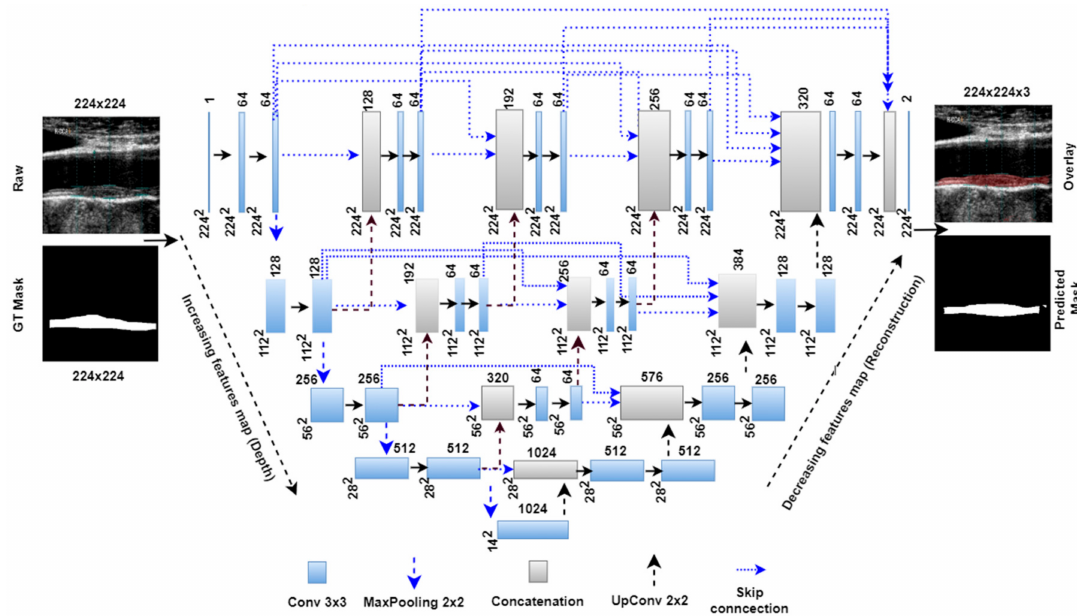
Figure 3. Unet++ model with four encoder and decoder